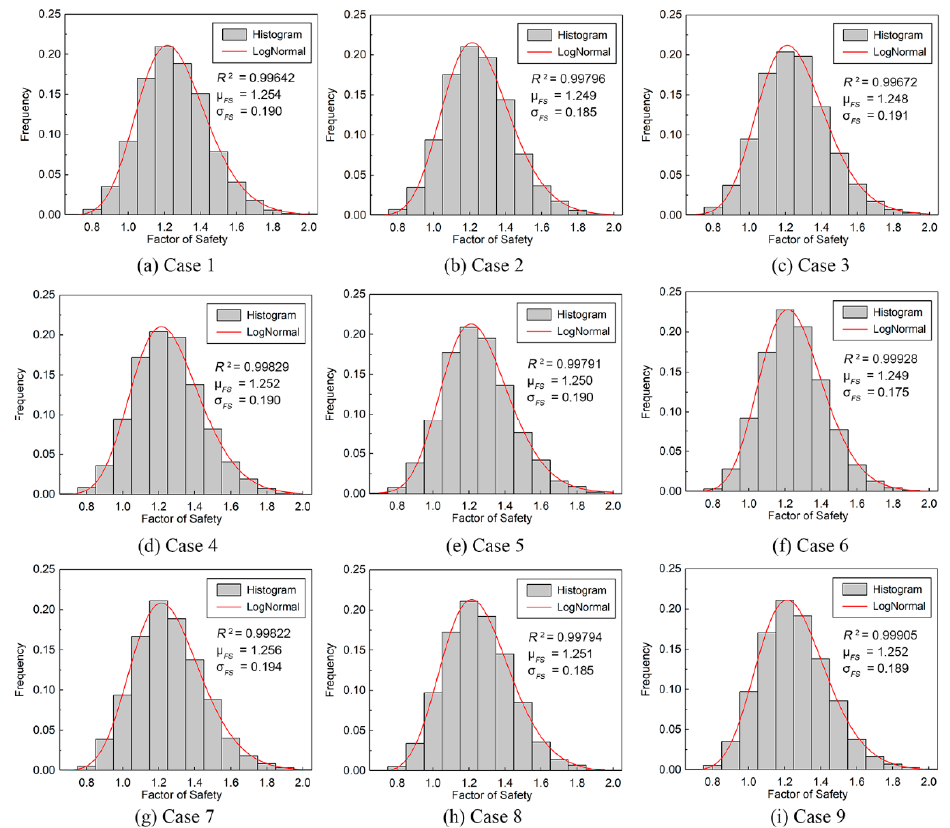
Figure 3. Typical realizations of random fields underlying S u (color online).